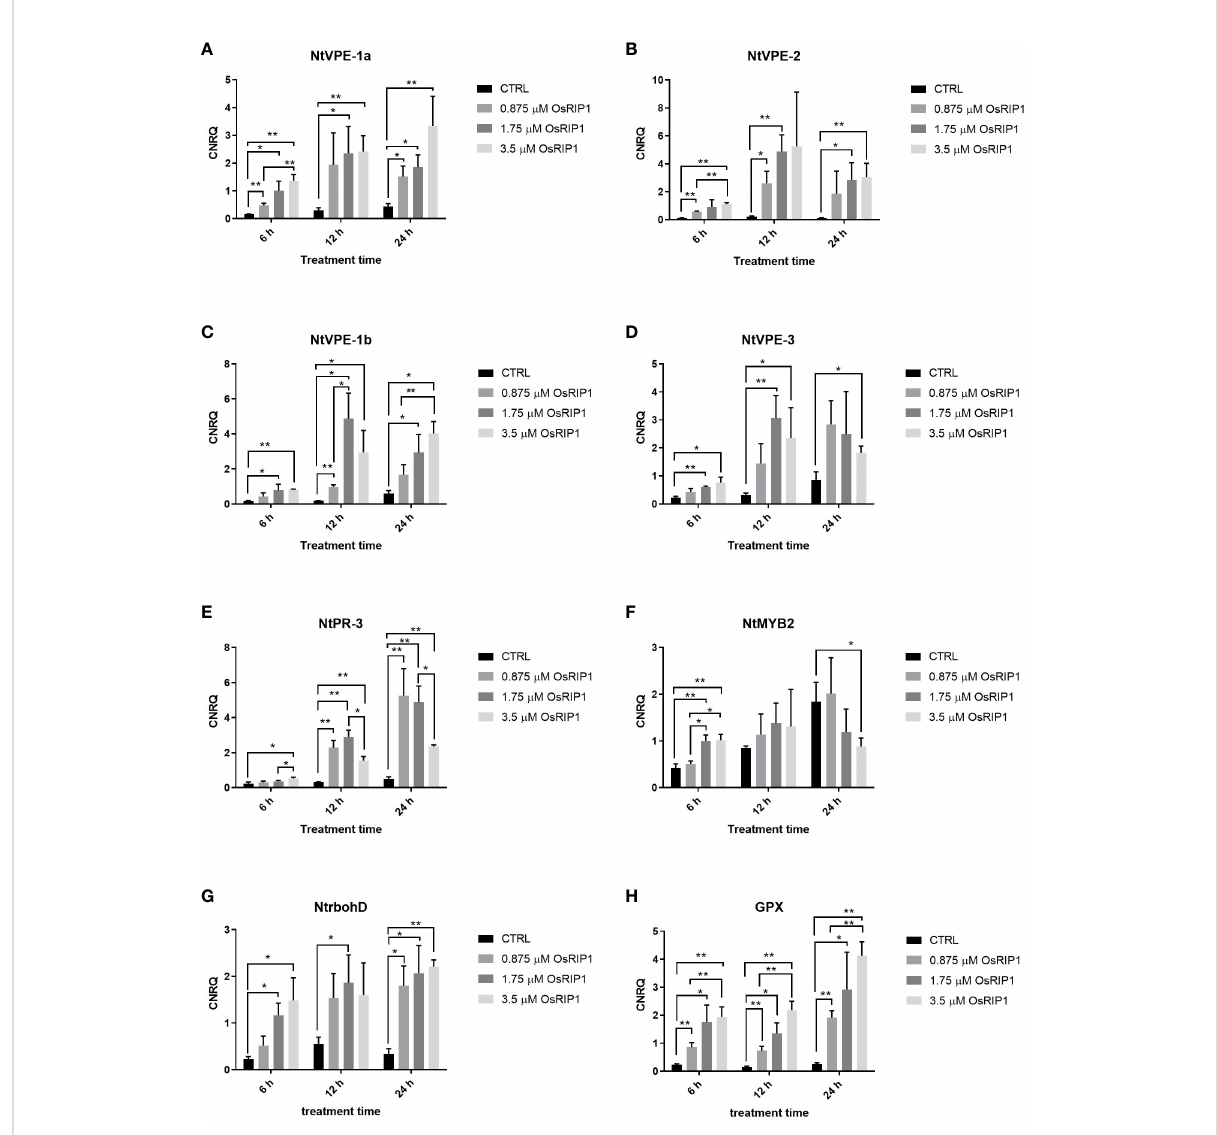
FIGURE 6 Relative expression levels (calibrated normalized relative quantities, CNRQ values) of genes of interest determined by RT-qPCR. Values are the mean ± SD of three independent experiments (n = 3). Asterisks indicate signi fi cant differences, which was determined by Multiple t -test, *p